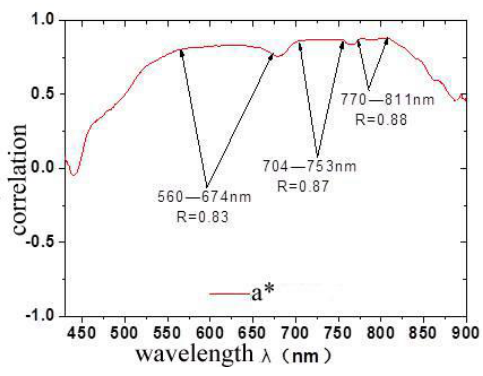
Figure 4. a* with the correlation of